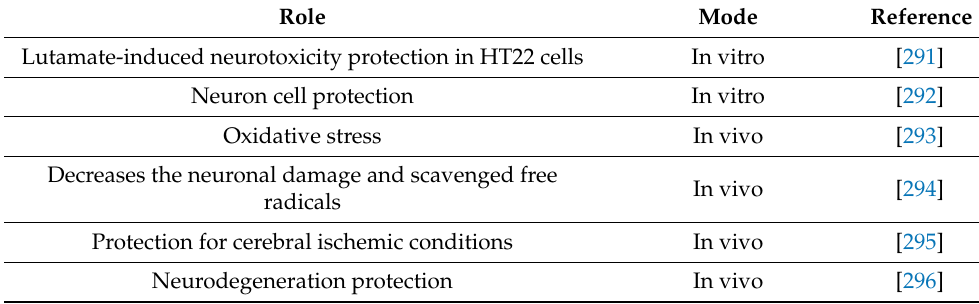
Table 2. Cont. Role Mode Reference Lutamate-induced neurotoxicity protection in HT22 cells In vitro Neuron cell protection Oxidative stress Decreases the neuronal damage and scavenged